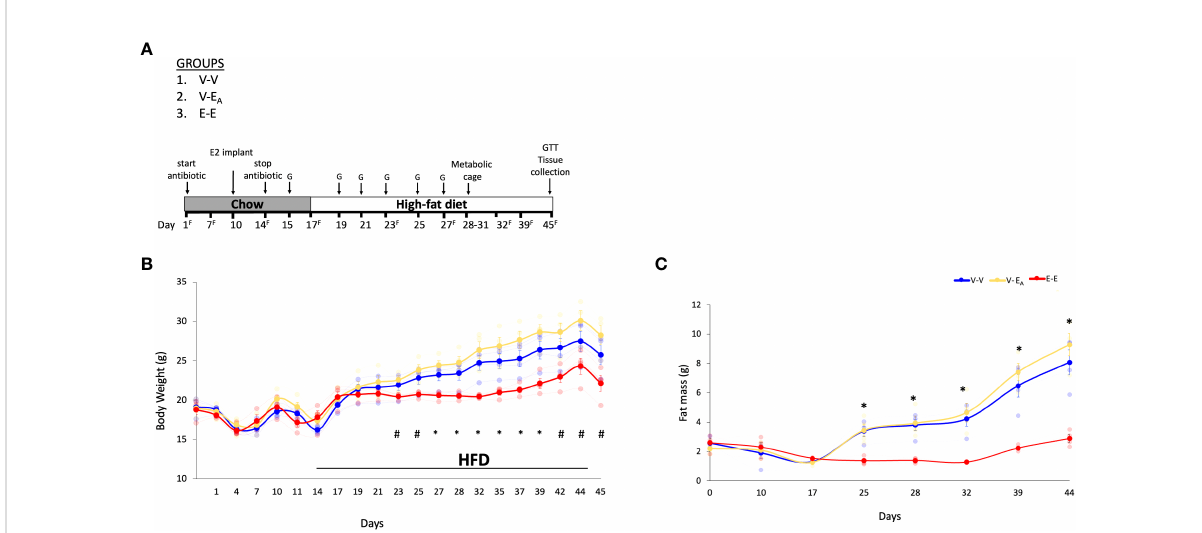
FIGURE 2 Estradiol treatment, but not fecal microbiota transplant (FMT) from lean E2-treated mice supplemented with A . muciniphila , protected ovariectomized mice from HFD-induced obesity. (A) A . muciniphila -enriched FMT study design and timeline. Recipient mice were administered antibiotic cocktail for the fi rst 14 days. The three recipient groups, 1) Veh mice receiving FMT from Veh mice (V-V, n = 4); 2) Veh mice receiving FMT from E2 mice following enrichment with Akkermansia cells (V-E A , n = 4), and 3) E2-implanted mice receiving FMT from E2 mice (E-E, n = 4) were orally gavaged with a total of 6 gavages on alternate days, starting on D15 and excluding D17. G denotes FMT gavage days; F denotes fresh fecal sample collection days. (B) Body weight and (C) Fat mass. *denotes days when E-E groups differ from V-V and V-E A ; # denotes days when E-E differ from V-E A only (p < 0.05, RM ANOVA, Tukey post-hoc ). V-V: mice with Veh implants receiving FMT from Veh mice; E-E: E2- treated mice receiving FMT from E2 mice; V-E A : mice with Veh implants receiving FMT from E2-treated mice with A . muciniphila